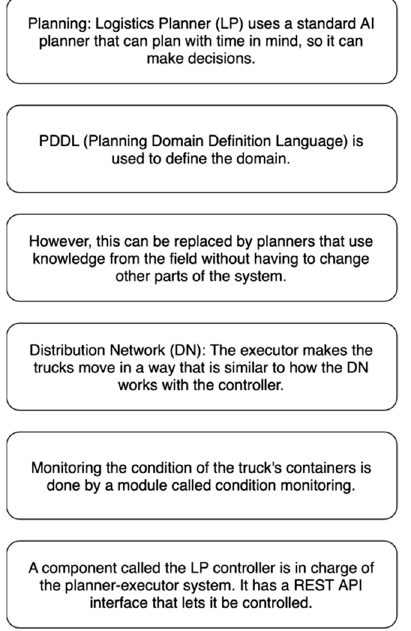
Figure 11. Key features of the Logistic Planner.